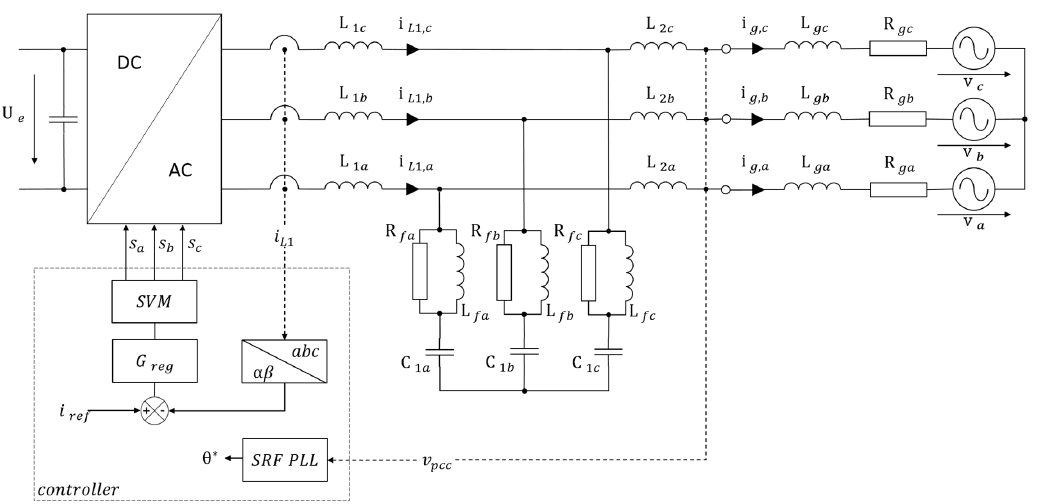
Figure 1. Principle schematic of the voltage source inverter (VSI) topology; SVM: Space Vector Modulation; SRF PLL: Synchronous Reference Frame Phase Locked Loop.